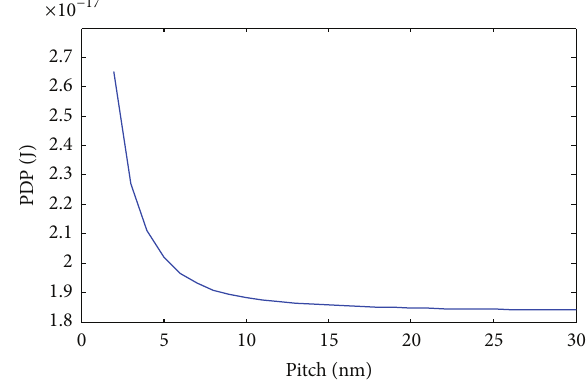
Figure 14: The effect of pitch on PDP for pure-CNFET inverter.